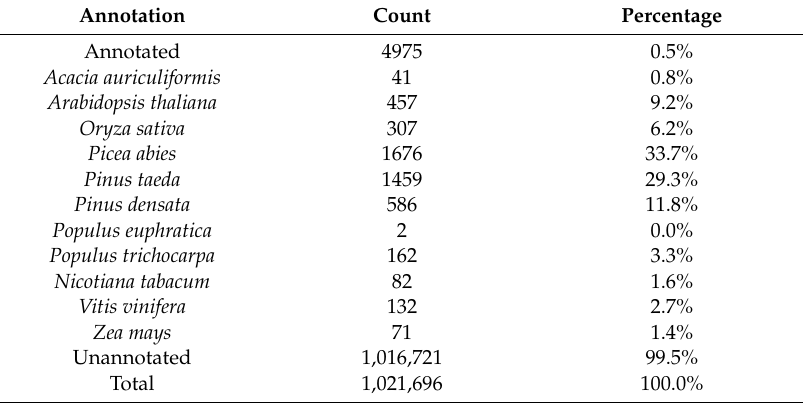
Table 1. Conserved small RNAs identified from